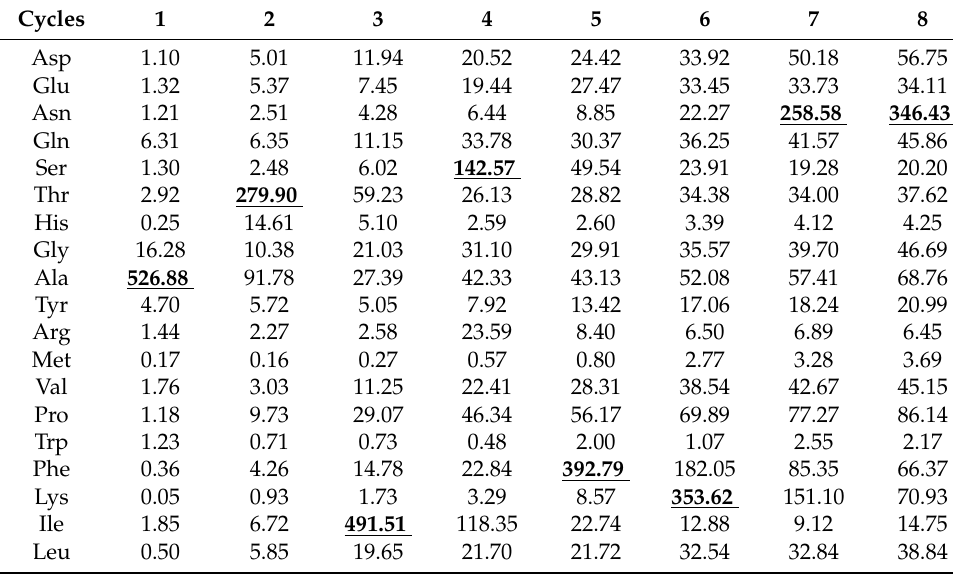
Table 1. Amino acid yield of Edman degradation. (Yield(pmol)).